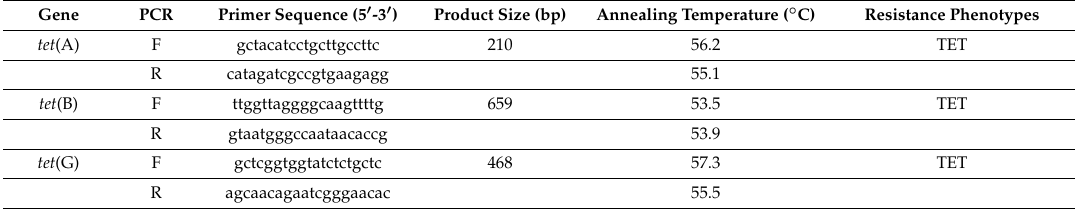
Table 2. Primers and annealing temperatures used in PCR assays for each resistance gene. Gene PCR Primer Sequence (5 (cid:48) -3 (cid:48) ) Product Size (bp) Annealing Temperature ( ◦